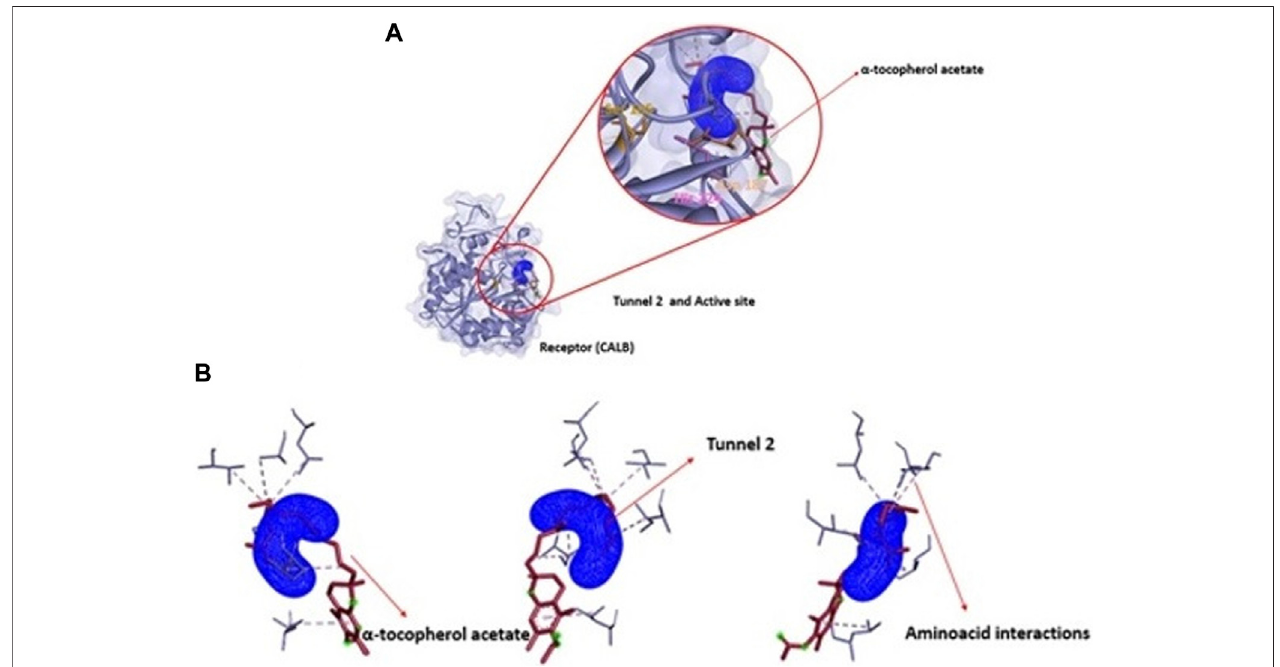
FIGURE 9 | (A) Structural representation of receptor (CALB), active site (Ser 105, Asp 187 and His 224) in relation to position of tunnel 1 and the ligand (Vinyl acetate). (B) : View of ligand Vinyl acetate (blue) in tunnel 1 (pink) apllied Caver Web in protein.